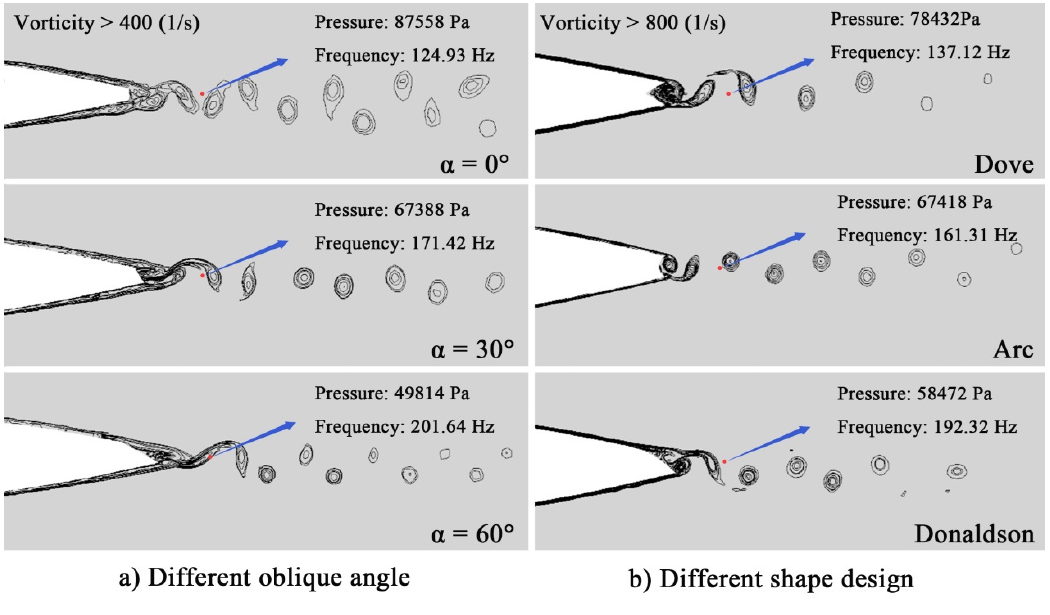
Figure 11. Results with different trailing edges.